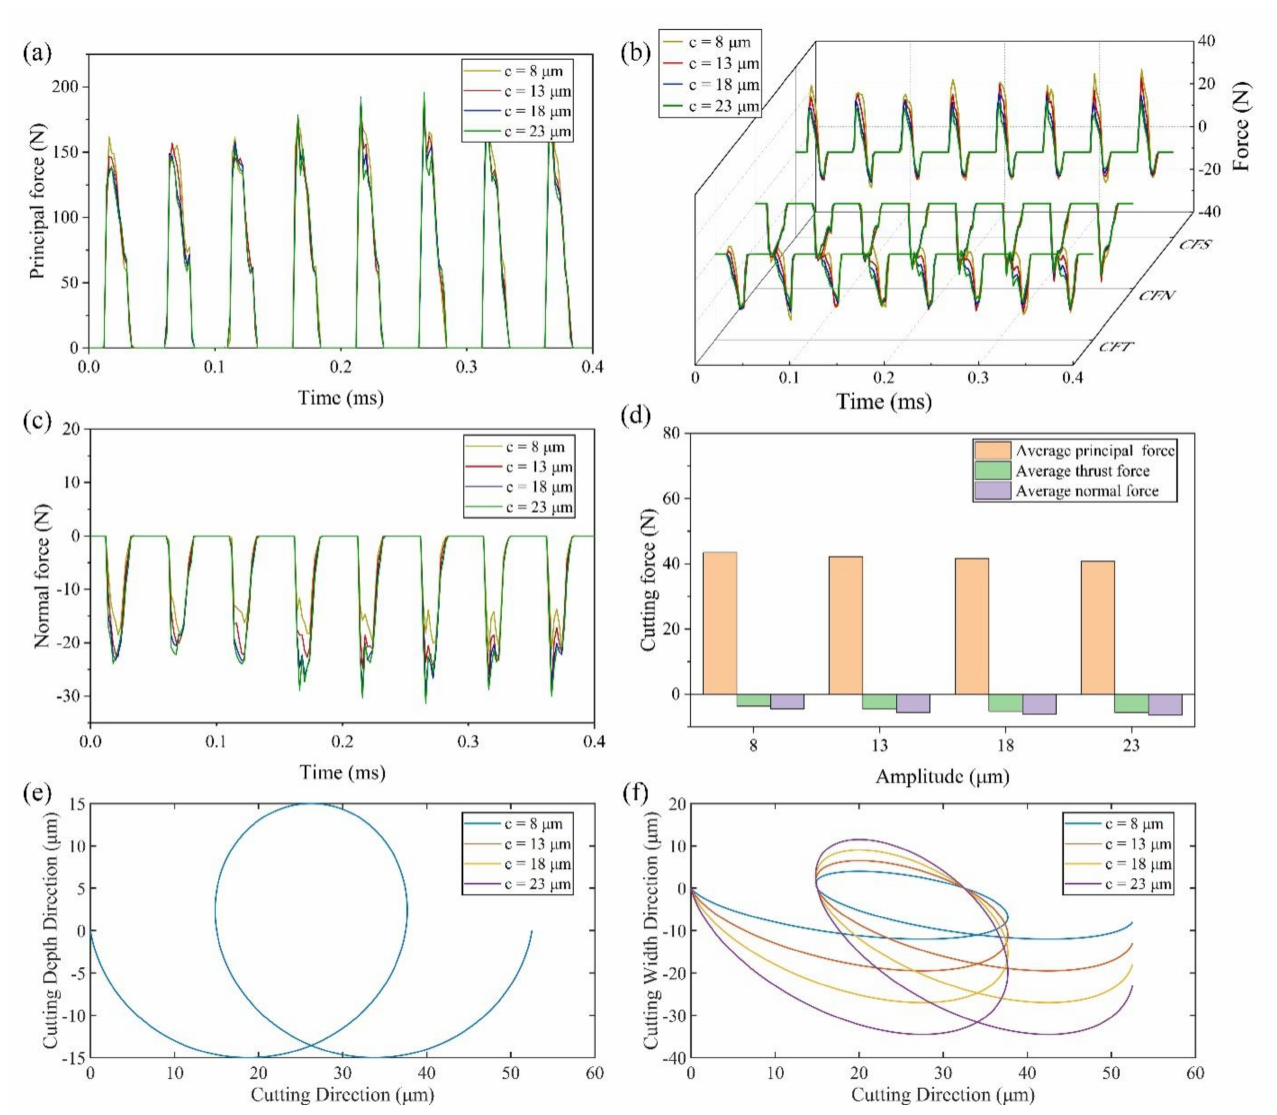
Figure 8. Results of cutting force and tool trajectories with various amplitudes c ( a ) principal force ( b ) thrust force ( c ) normal force ( d ) average cutting force ( e ) cutting trajectory with various amplitudes c in XoY plane ( f ) cutting trajectory with various amplitudes c in XoZ